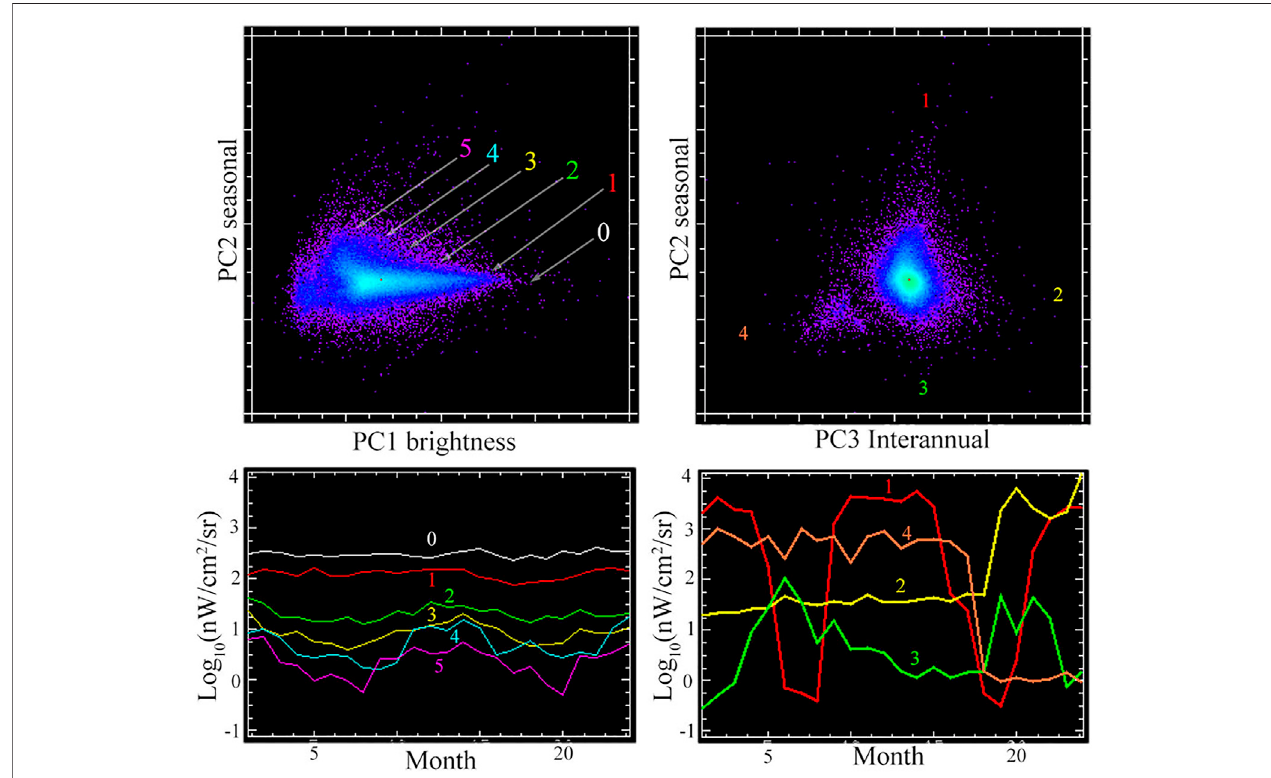
FIGURE6| Temporalfeature space andexampletime seriesfor2019+2020monthlymeanwithluminance threshold applied. Seasonalvariabilitydiminishes with increasing brightness (left) , Brightness changes signi fi cantly greater than month to month variability occur, but are exceedingly rare (right) .